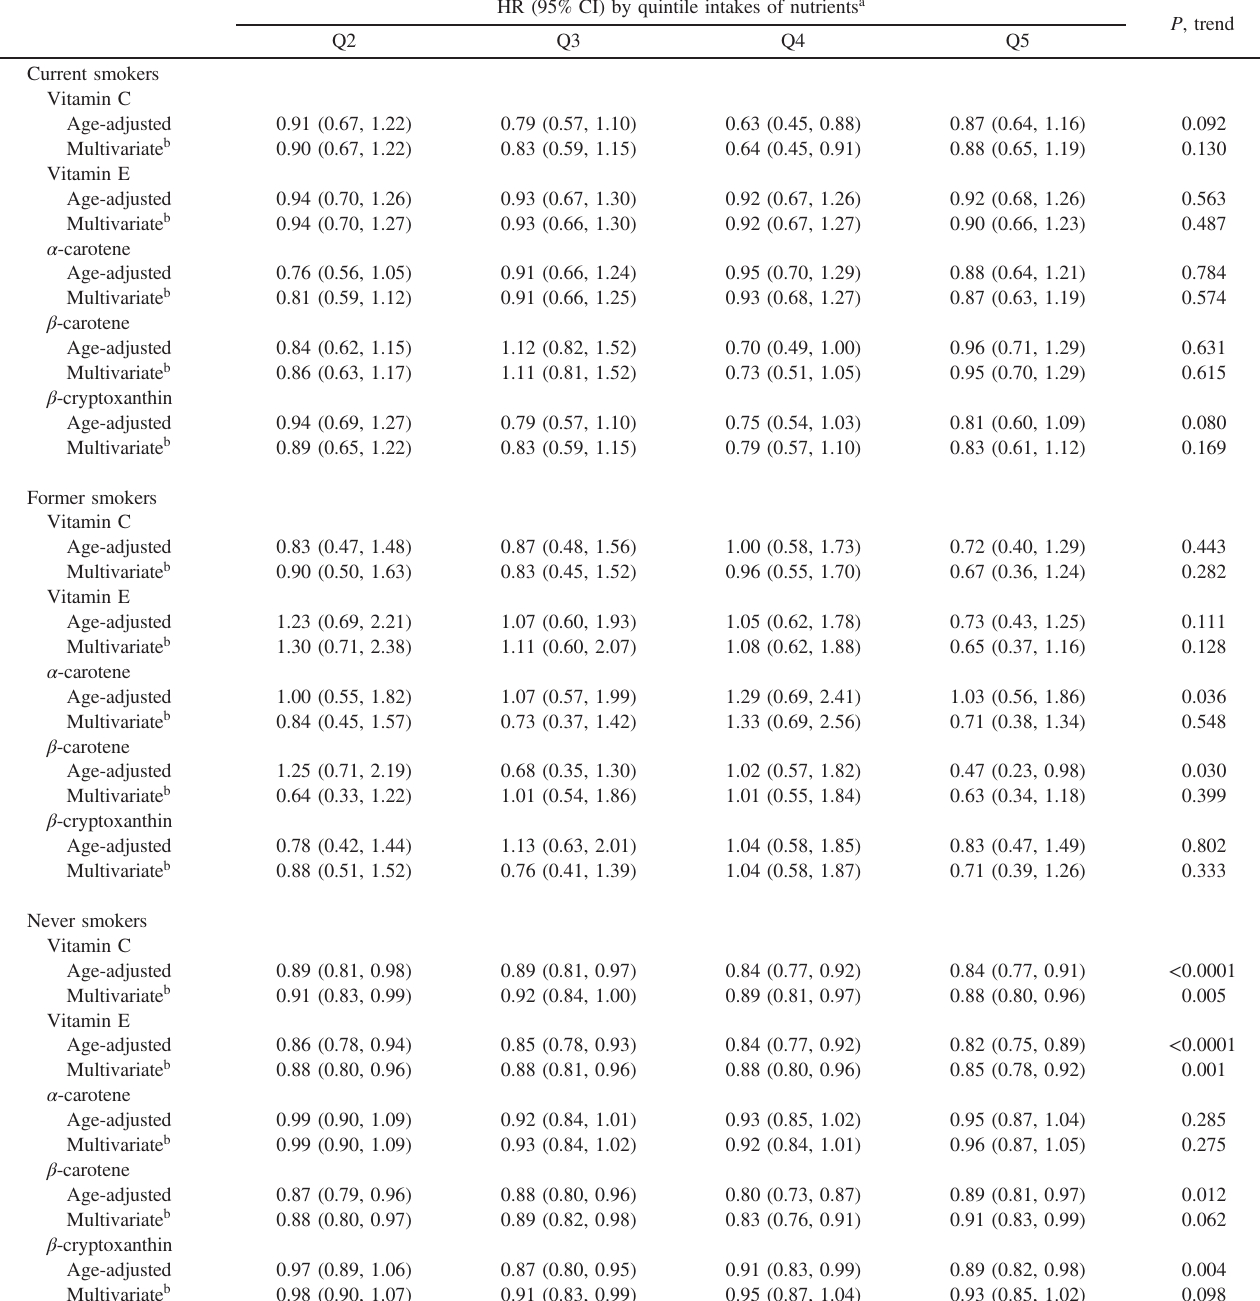
Table 5. Associations between energy-adjusted dietary antioxidant nutrients and all-cause mortality in women of current, former and never smokers, JACC